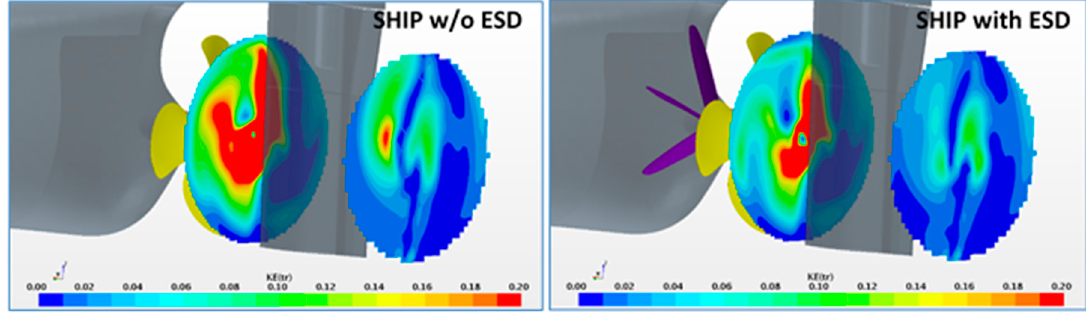
Figure 10. Distribution of the kinetic energy of transverse flow on sections “Sect 2” and “Sect 3” downstream of the propeller (PSS-Var-5, full scale, Vs = 14 kn).